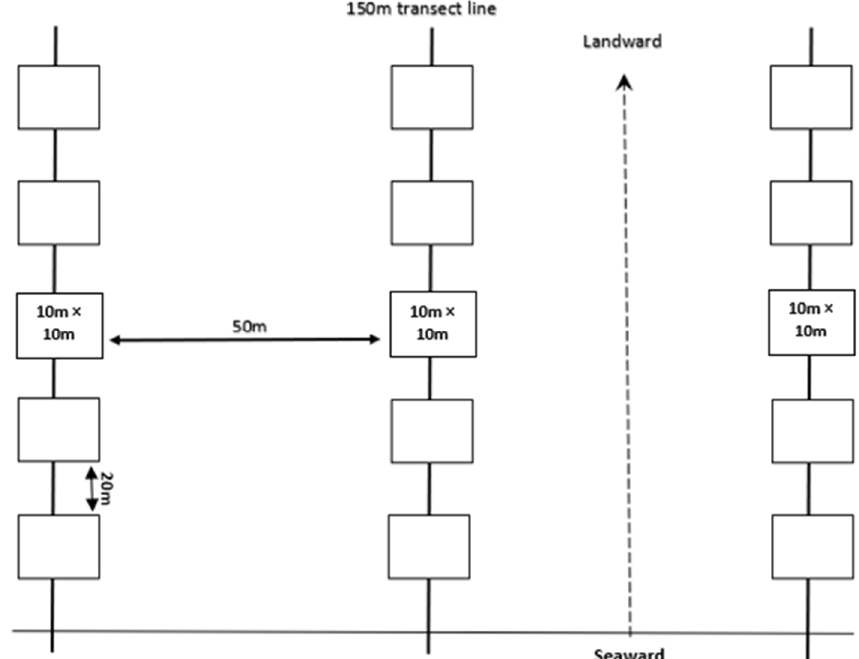
Figure 2. Strip-split plot sampling design that was used in the study.